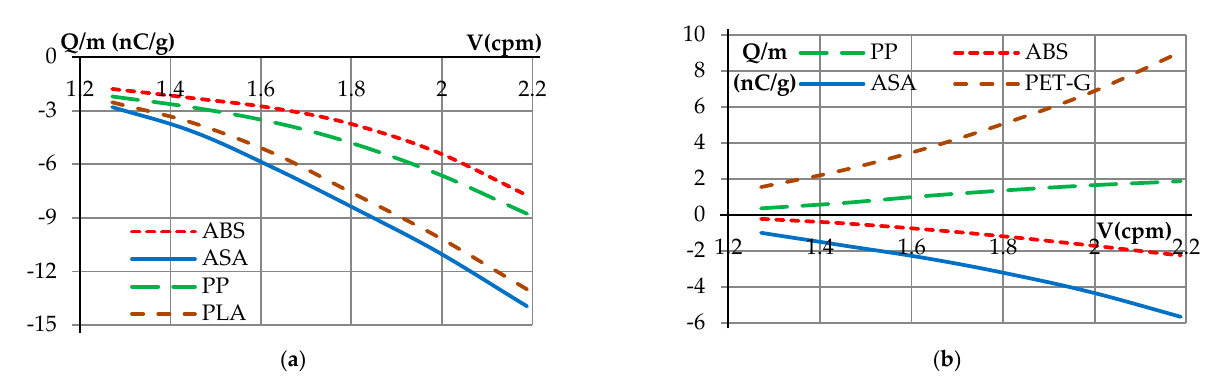
( b ) Figure 12. Charge density per mass as a function of airflow for tribocharging process of ( a ) PET in the container made of PP; ( b ) PE-HD in the container made of PET-G for a constant time of the charging process t = 30 s for fraction mass 10 g. Studies of the electrification of the two materials in containers made of selected materials were also performed. It was tested in which of the containers both polymers would electrify with opposite charges—Figure 13. In addition to poly(ethylene tereph- thalate) glycol-modified (PET-G and polypropylene copolymer (PP) containers, contain- ers